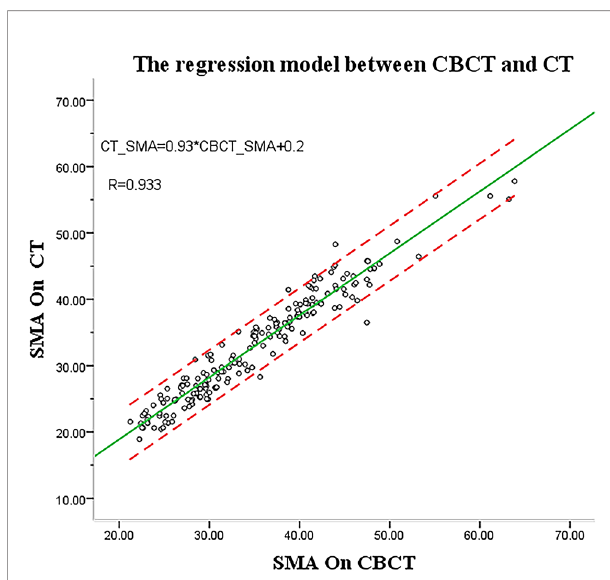
FIGURE 4 | Analysis of skeletal muscle estimation using cone-beam computed tomography